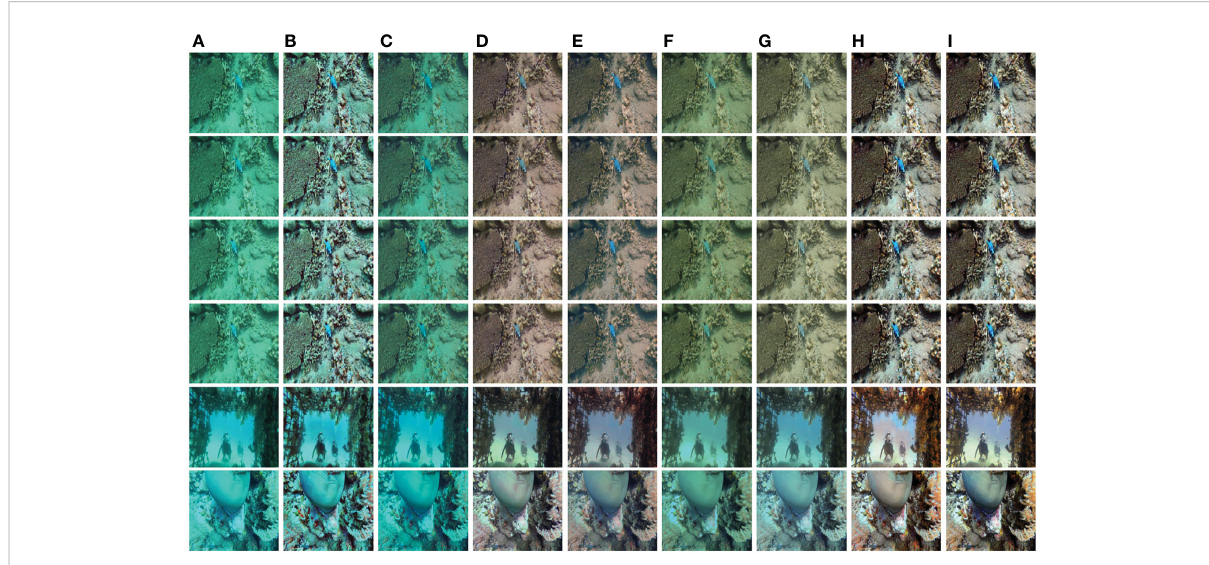
FIGURE 9 Visual comparisons of the 1280×960 frames in the underwater video. From left to right, (A) shows the raw underwater images, (B – I) are the results of CLAHE (Pizer et al., 1990), OMGD (Ren et al., 2021), FUnIE-GAN (Islam et al., 2020), WaterNet (Li et al., 2019), UWCNN (Li et al., 2020), Shallow-UWnet (Naik et al., 2021), Spiral-GAN (Han et al., 2020) and the proposed model, respectively.